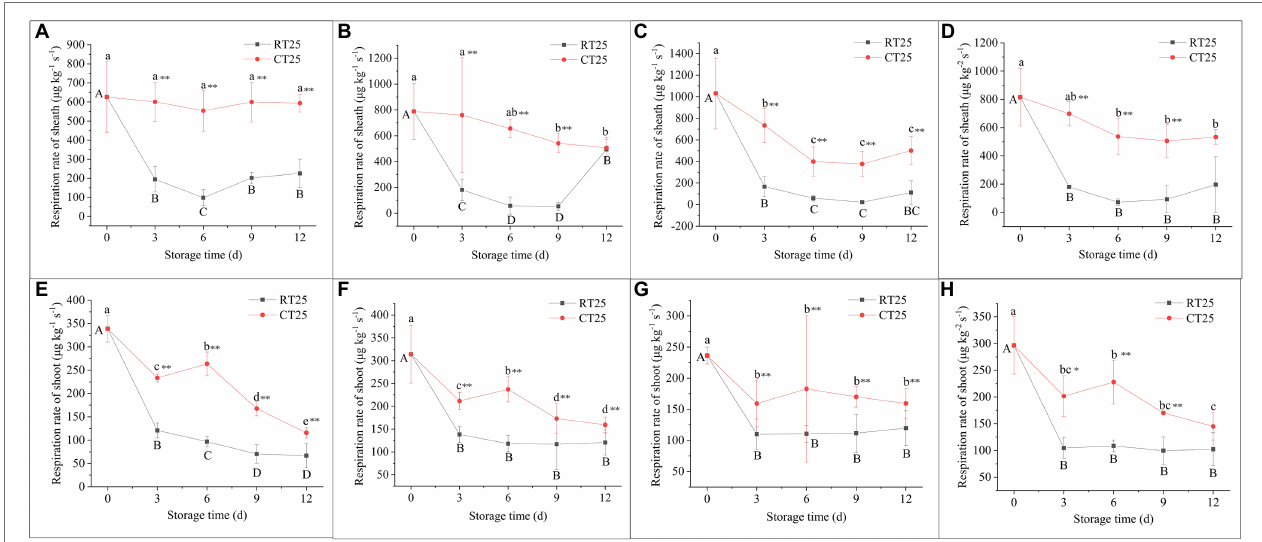
FIGURE 3 | Respiration rates in bamboo shoot sheaths and shoots. (A–D) Respiration rates of sheaths under different storage conditions. (E–H) Respiration rates of shoots under different storage conditions. (A) Respiration rates of the sheaths in the upper plant parts of the bamboo shoots during storage at 25 ° C and 4 ° C. (B) Respiration rates of the sheaths in the middle plant parts of the bamboo shoots during storage at 25 ° C and 4 ° C. (C) Respiration rates of the sheaths in the bottom plant parts of the bamboo shoots during storage at 25 ° C and 4 ° C. (D) Mean respiration rates of the sheaths in all parts of the bamboo shoots during storage at 25 ° C and 4 ° C. (E) Respiration rates of the upper parts of bamboo shoots during storage at 25 ° C and 4 ° C. (F) Respiration rates in the middle plant parts of the bamboo shoots during storage at 25 ° C and 4 ° C. (G) Respiration rates in the bottom plant parts of the bamboo shoots during storage at 25 ° C and 4 ° C. (H) Mean respiration rates in all plant parts of the bamboo shoots during storage 25 ° C and 4 ° C. RT25, bamboo shoots stored at room temperature and analyzed at 25 ° C and CT25, bamboo shoots stored at cold temperatures and analyzed at 25 ° C. Data are presented as mean ± standard deviation ( n = 3). Significant analysis was performed using the Student’s t -test, in which different letters represent significant difference between treatments within the group, and the asterisk represents the level of significance between groups ( * means the difference is significant at the 0.05 level, ** means the difference is significant at the 0.01